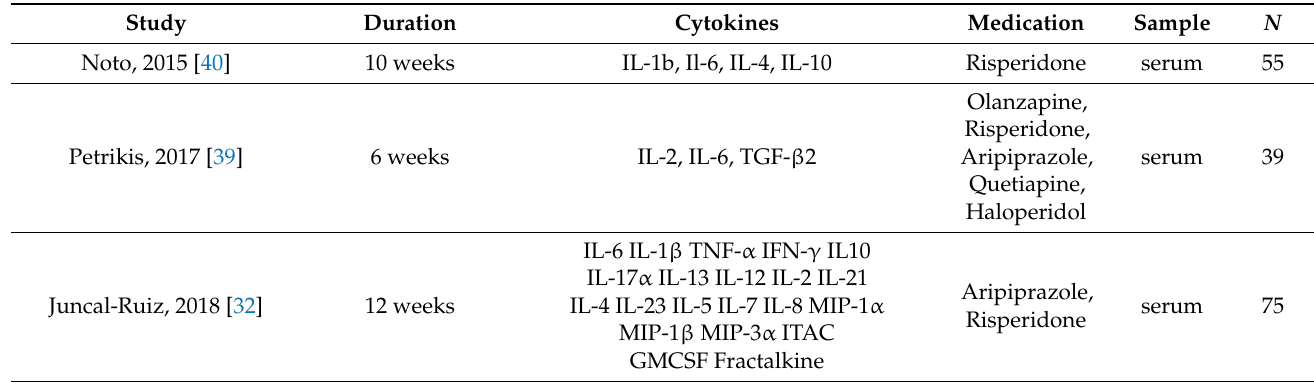
Table 2. Characteristics of included